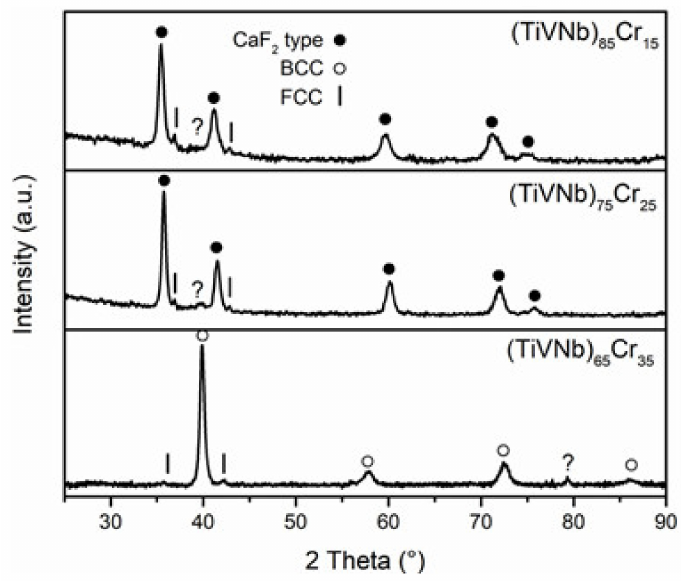
Figure 7. Indexed XRD patterns of (TiVNb) 85 Cr 15 , (TiVNb) 75 Cr 25 and (TiVNb) 65 Cr 35 alloys after the first hydrogen